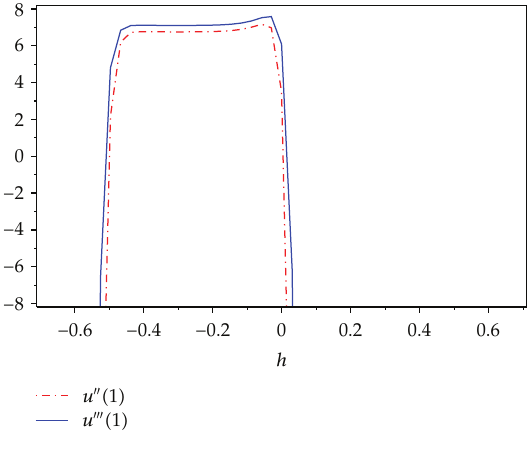
Figure 5: 16th-order SHAM h